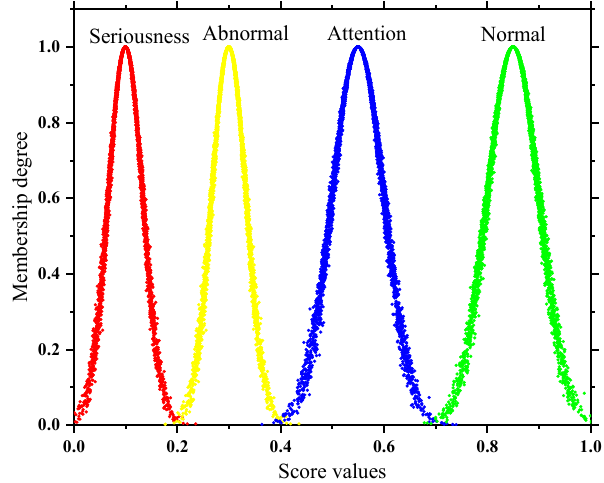
Figure 2. State space of quantitative indicator.